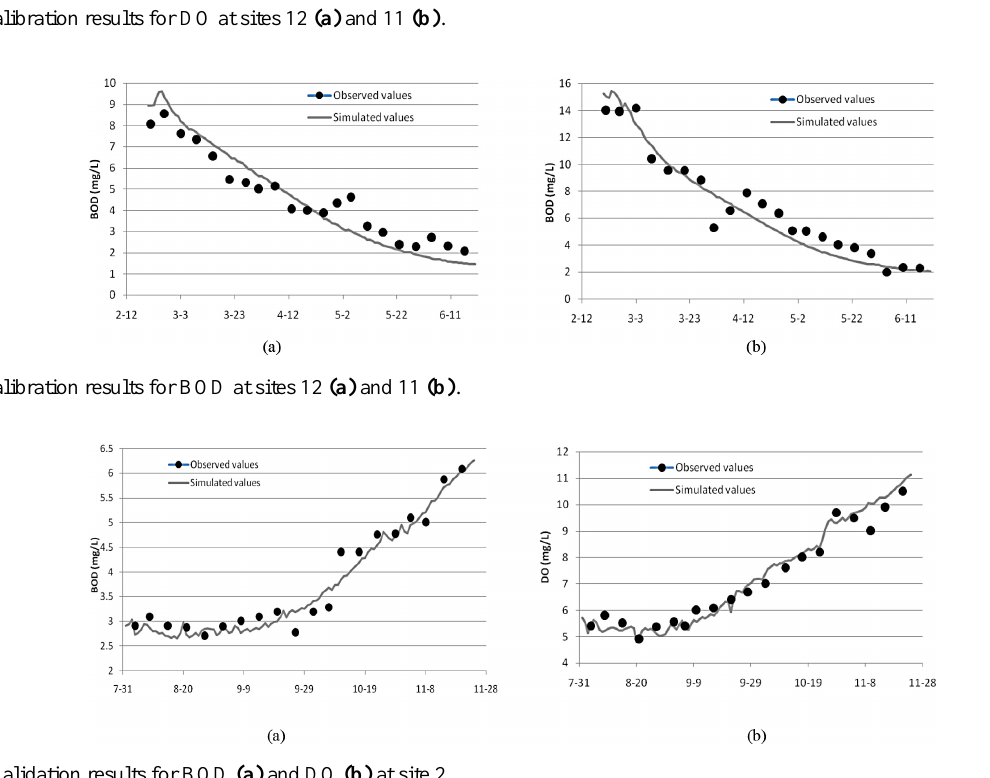
Figure 10. Validation results for BOD (a) and DO (b) at site